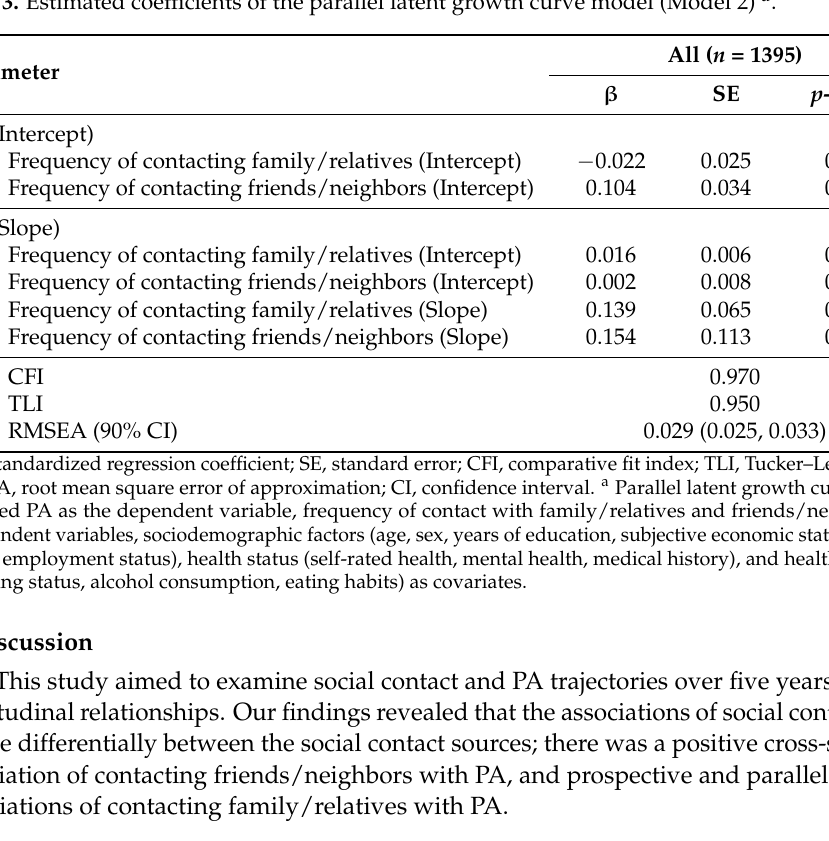
Table 3. Estimated coefficients of the parallel latent growth curve model (Model 2) a